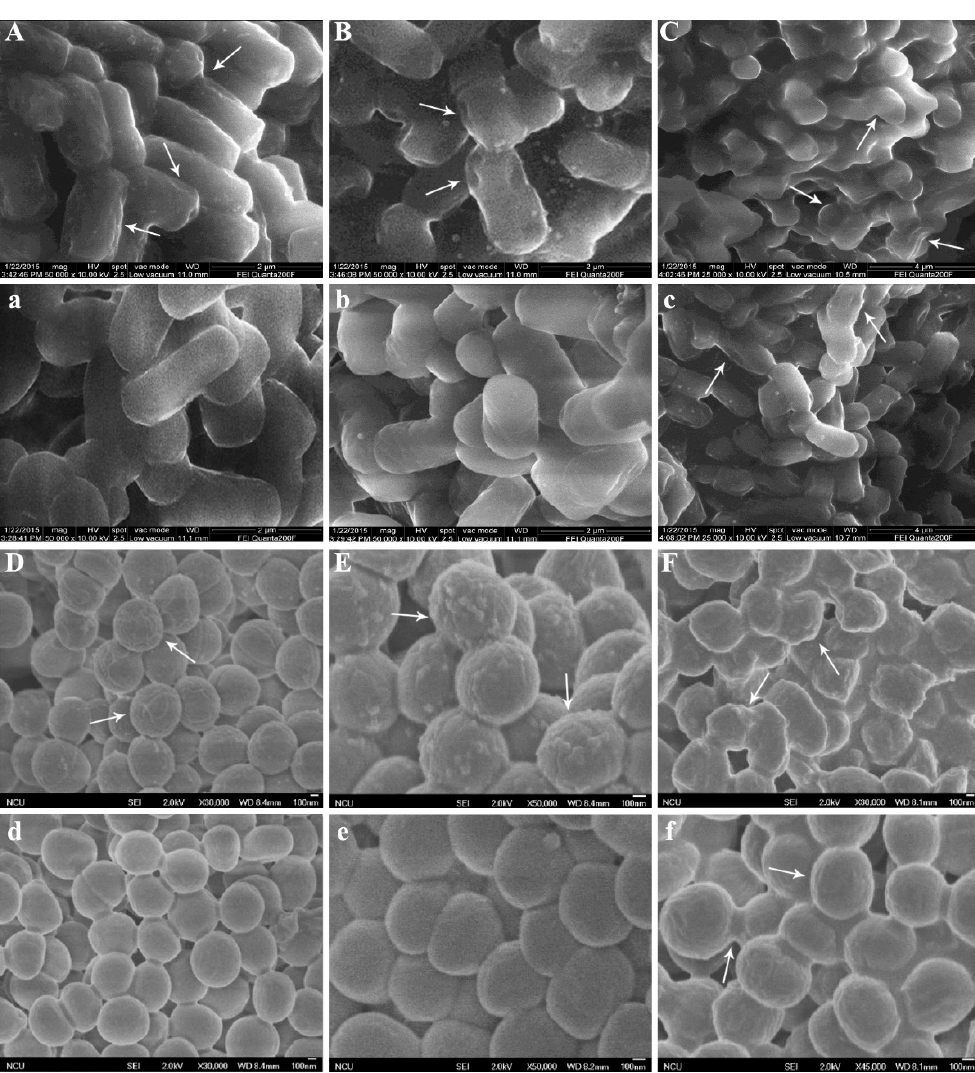
Figure 3. Morphology of bacteria treated (uppercase letters) and untreated (lowercase letters) with DMY. ( A and a ): E. coli for 4 h, ( B and b ): E. coli for 14 h, ( C and c ): E. coli for 24 h, ( D and d ): S. aureus for 4 h, ( E and e ): S. aureus for 14 h, ( F and f ): S. aureus for 24 h.